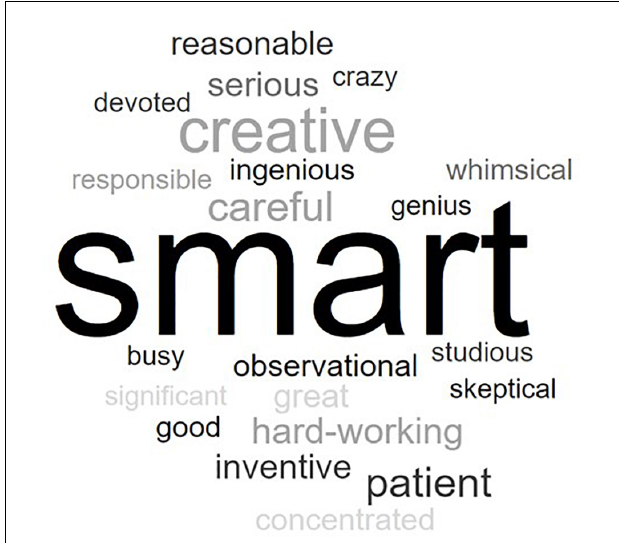
FIGURE 1 | Word Cloud presenting the most frequent descriptions of scientists.